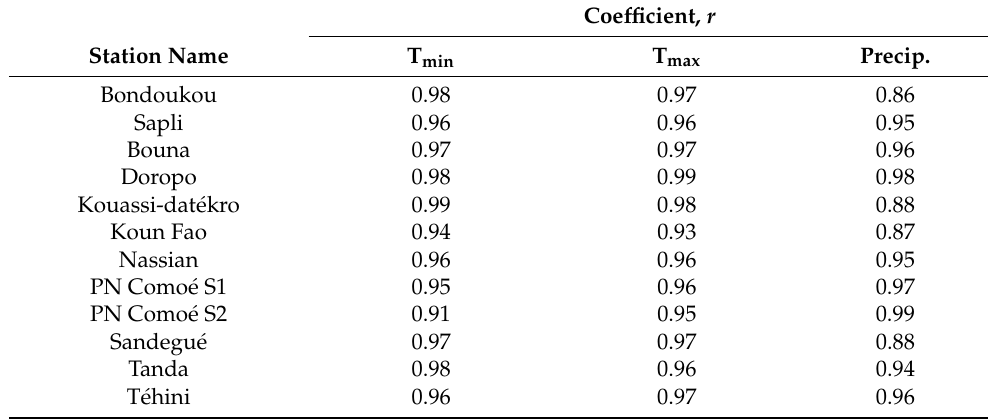
Table 2. Pearson’s correlation coefficient ( r ) between the ground data (SODEXAM) and NASA POWER for the twelve